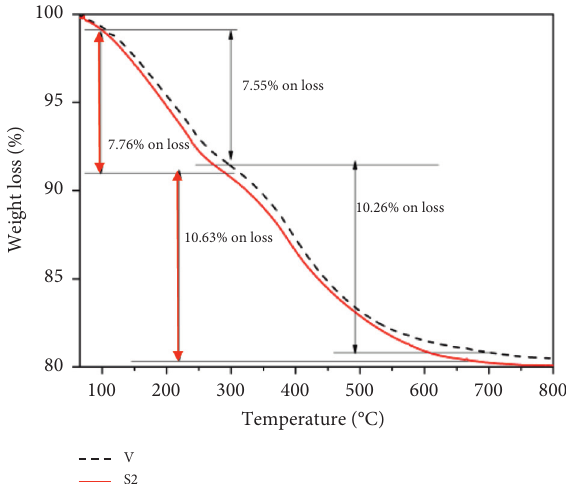
Figure 8: TG curves of slag solidified body without adding SiC whisker (V) and with 1% SiC whisker (S2).